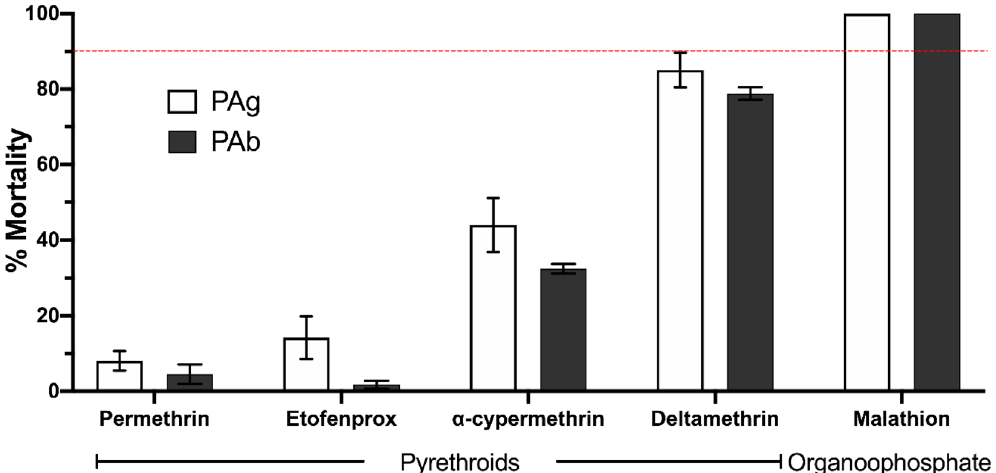
Figure 2. Adulticide bioassays with Aedes aegypti and Aedes albopictus from Lahore, Pakistan. PAg and PAb designate Ae. aegypti and Ae. albopictus populations, respectively. Dose-diagnostic tests with the pyrethroids permethrin (0.25%), etofenprox (0.5%), alpha-cypermethrin (0.03%) and deltamethrin (0.03%) in WHO test tubes, and the organophosphate malathion (20 µg) in bottle assays. Bars and errors indicate the mean mortality ± SEM. Populations below 90% of mortality (indicated by the red dotted line) are resistant. Aedes aegypti Rockefeller reached 100% mortality in all assays run in parallel.